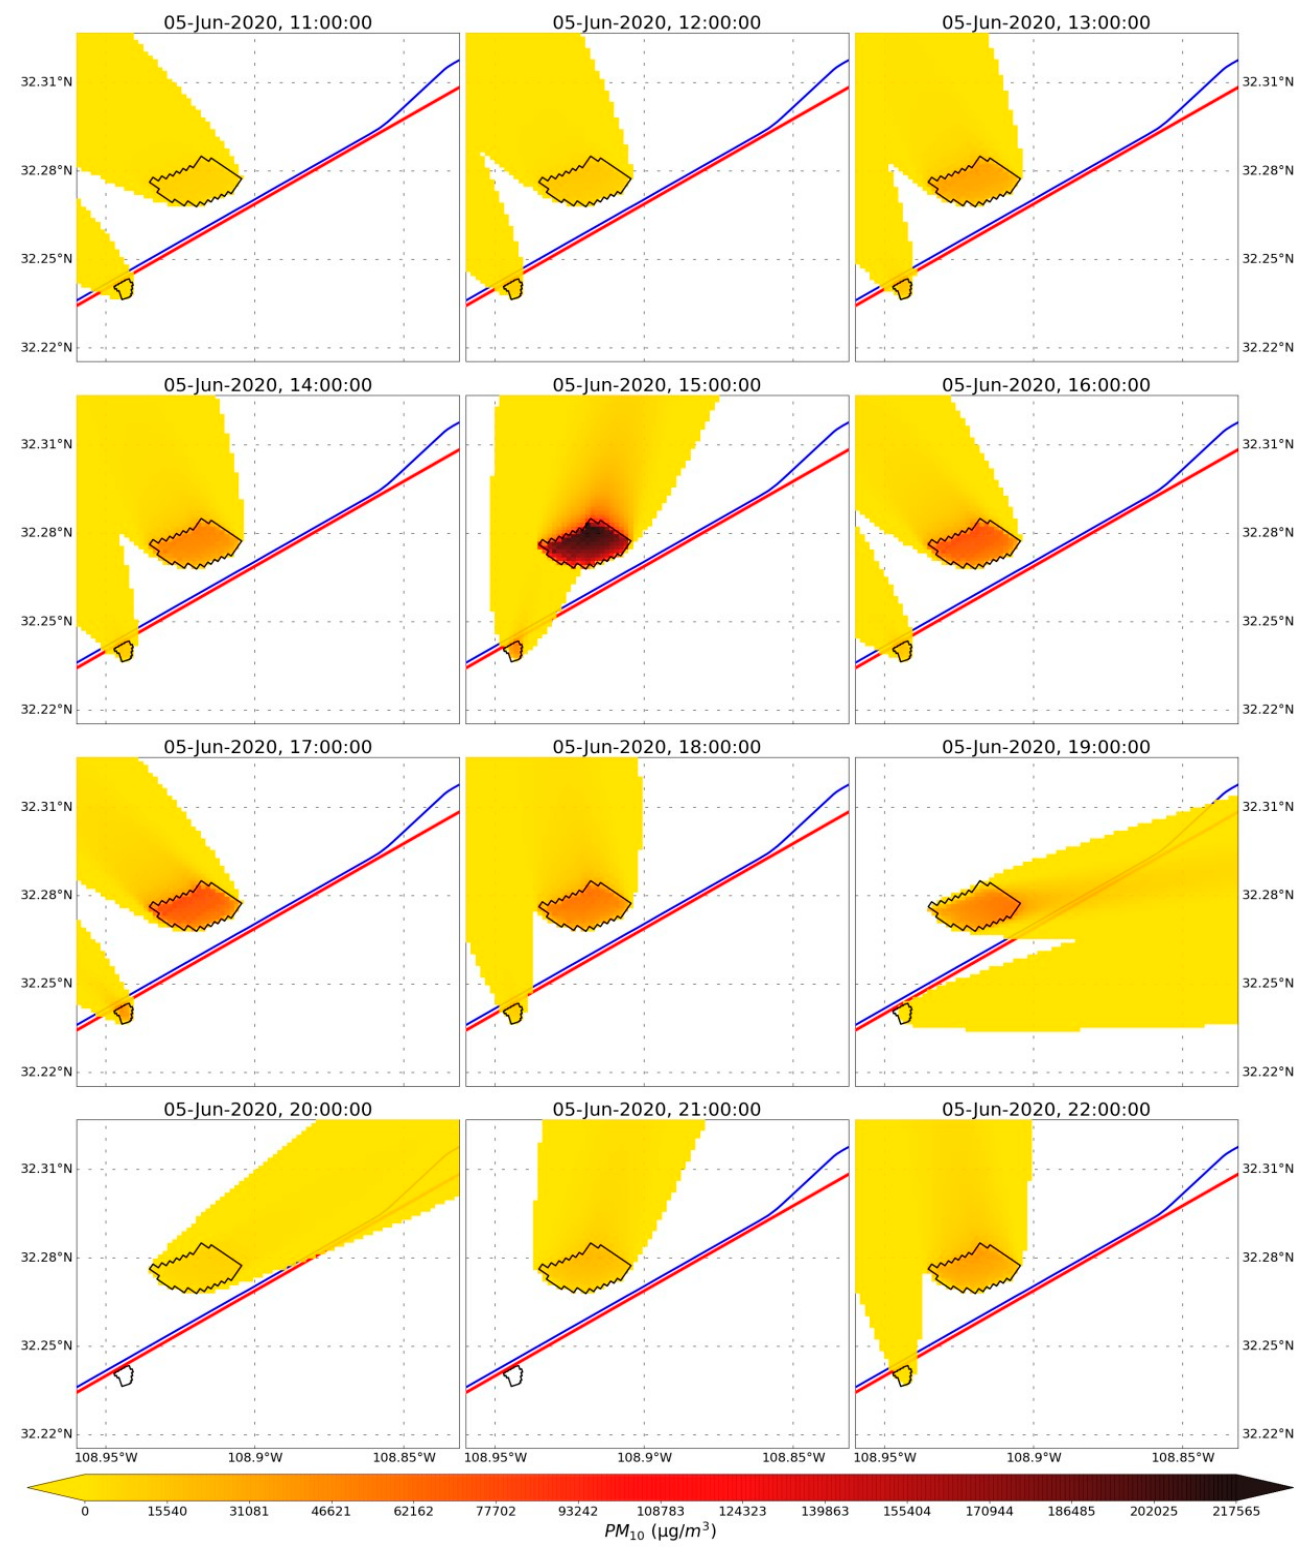
Figure 13. Hourly dispersion of PM 10 over Lordsburg Playa simulated by AERMOD for the dust event day of 5 June 2020. The two closed polygons represent the PM 10 sources. The red and blue lines represent I-10 and the Union Pacific Railroad, respectively.